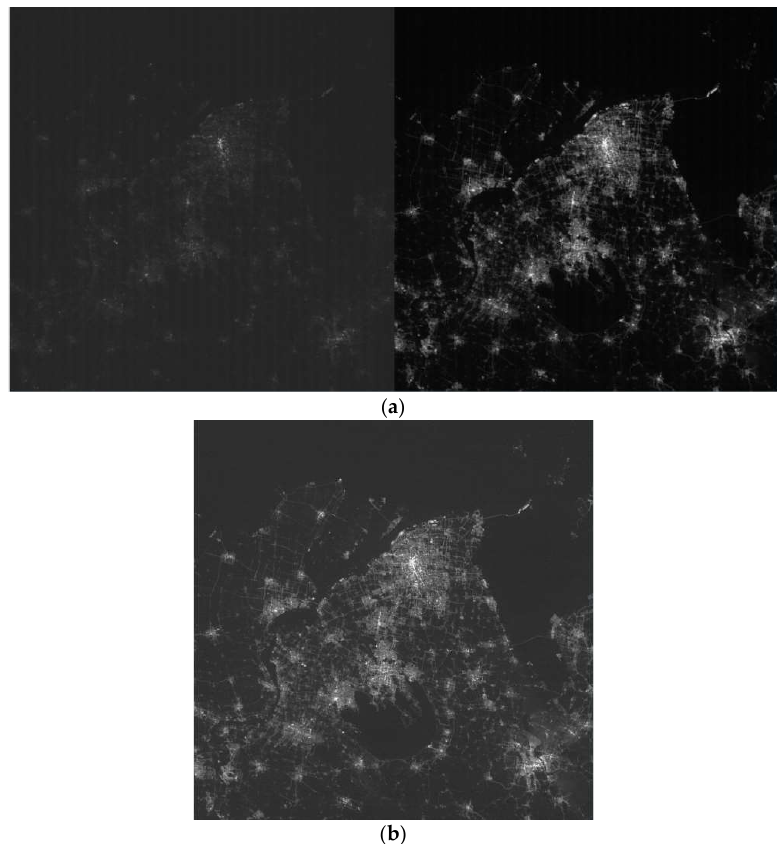
Figure 15. ( a ) Original image of low gain and high gain mode; ( b ) HDR image constructed by low gain and high gain image.